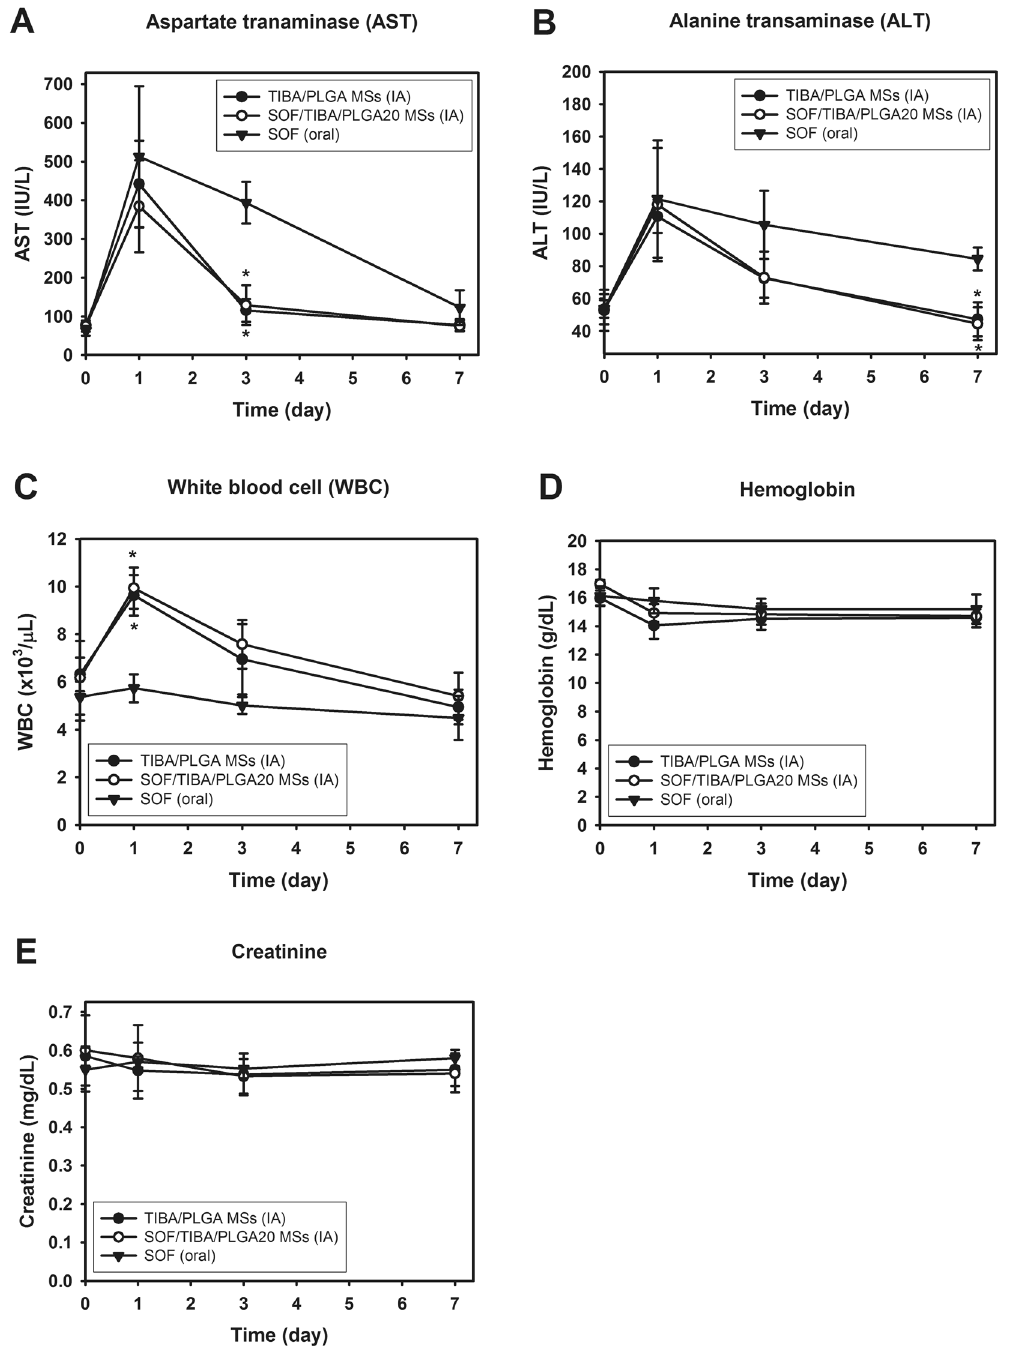
Figure 8. In vivo toxicity test after administration of SOF solution (oral), SOF/TIBA/PLGA20 MSs (IA), and TIBA/PLGA MSs (IA). The profiles of AST ( A ), ALT ( B ), WBC ( C ), hemoglobin ( D ), and creatinine ( E ) levels in the blood at day 0, 1, 3, and 7 are presented. Each point indicates means ± SD ( n = 4). * p < 0.05, compared with SOF (oral)